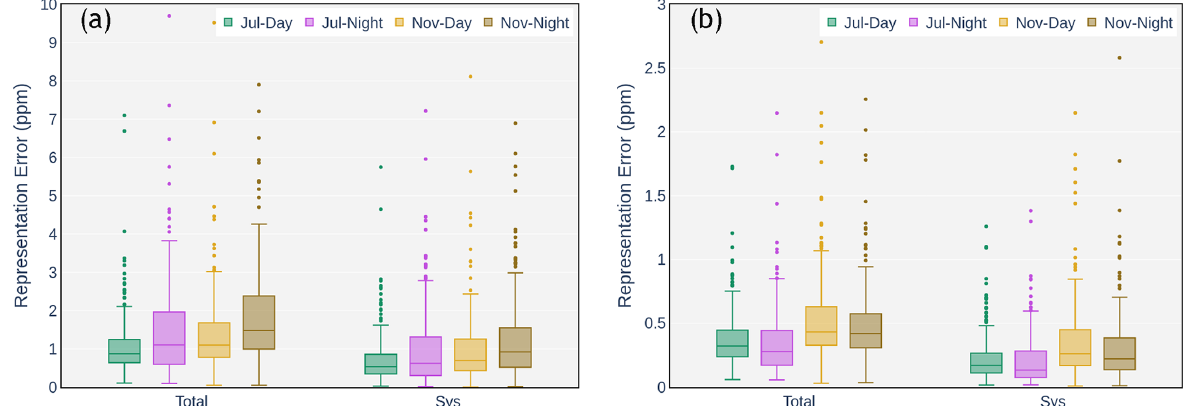
Figure 6. Variability in derived representation error over India in July and November 2017 (both during daytime and nighttime). Boxes indicate the central 50%, the bar across the box is the median value, and the whiskers indicate the values between the 5th and 95th percentiles. Individual data points shown are the outliers. (a) Representation error estimated for the surface CO 2 . (b) Representation error estimated for the column-averaged CO 2 .